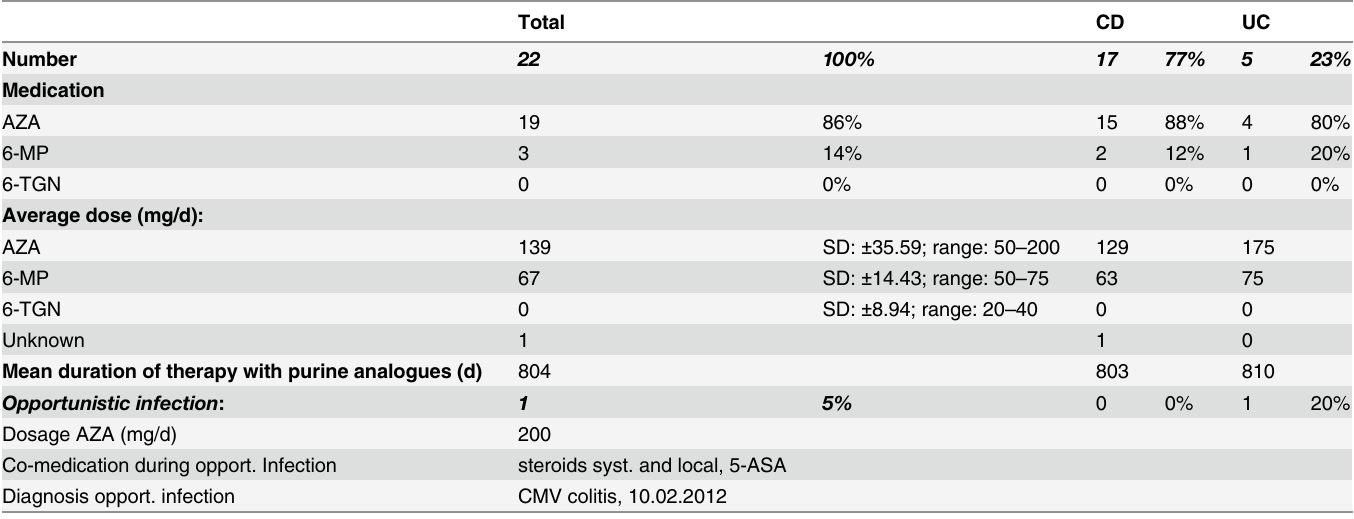
Table 7. Control